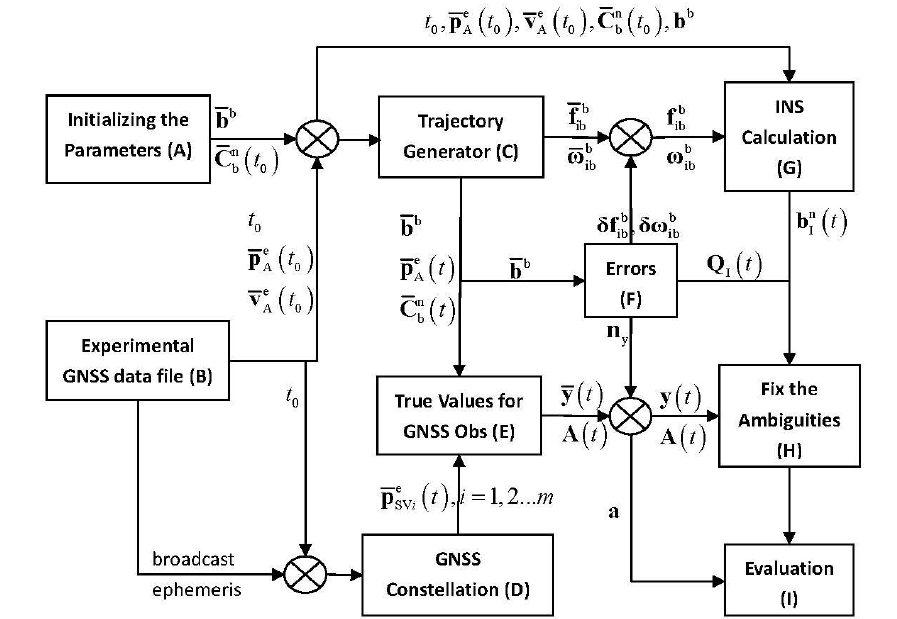
Figure 4. Simulation flow chart of inertial attitude augmentation for SF/SE-GNSS ambiguity